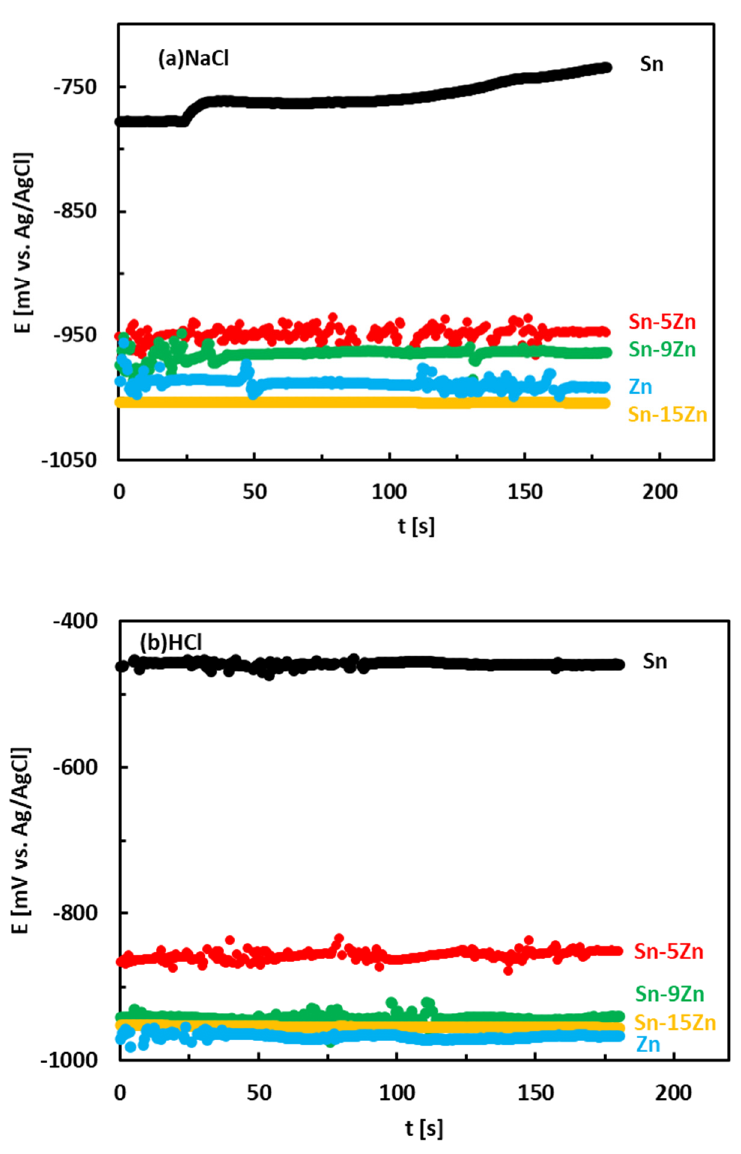
Figure 4. Room-temperature open circuit potentials of the Sn–Zn alloys in aqueous solutions of NaCl ( a ) and HCl ( b ).